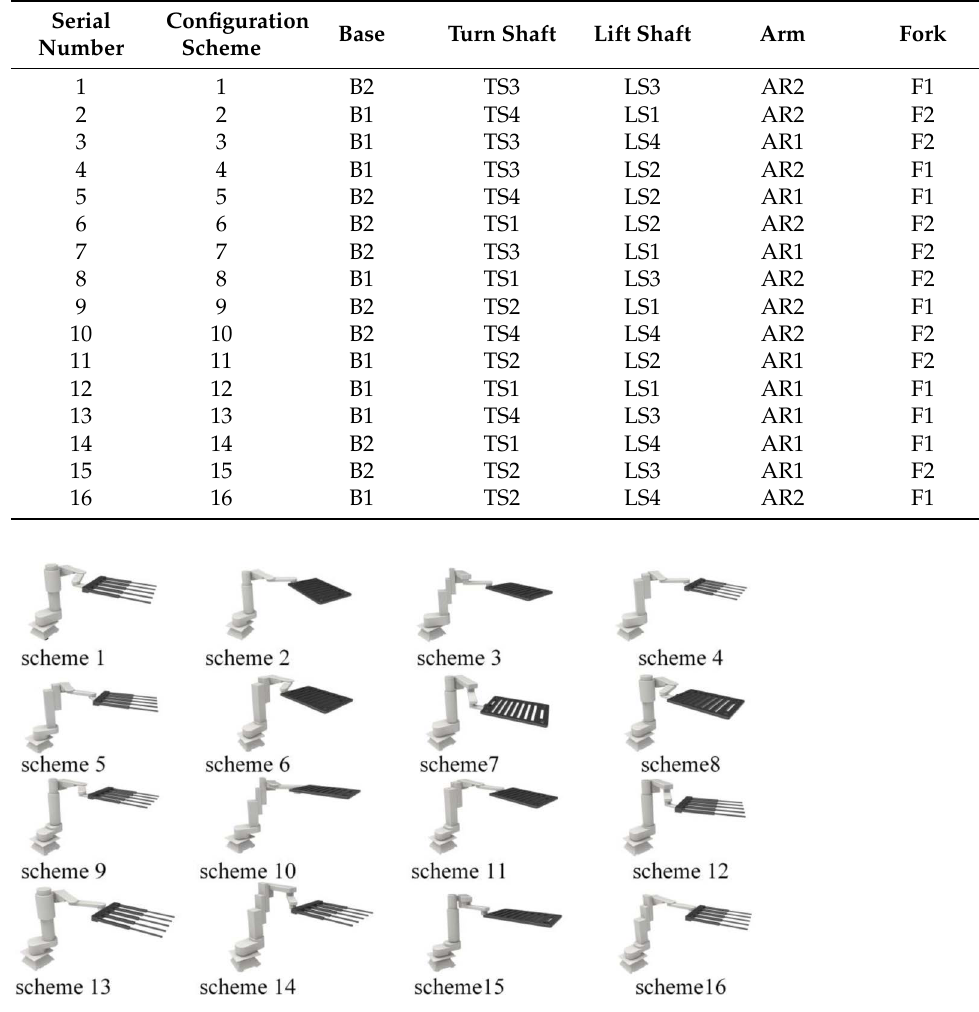
Figure 6. The result of 16 module combination